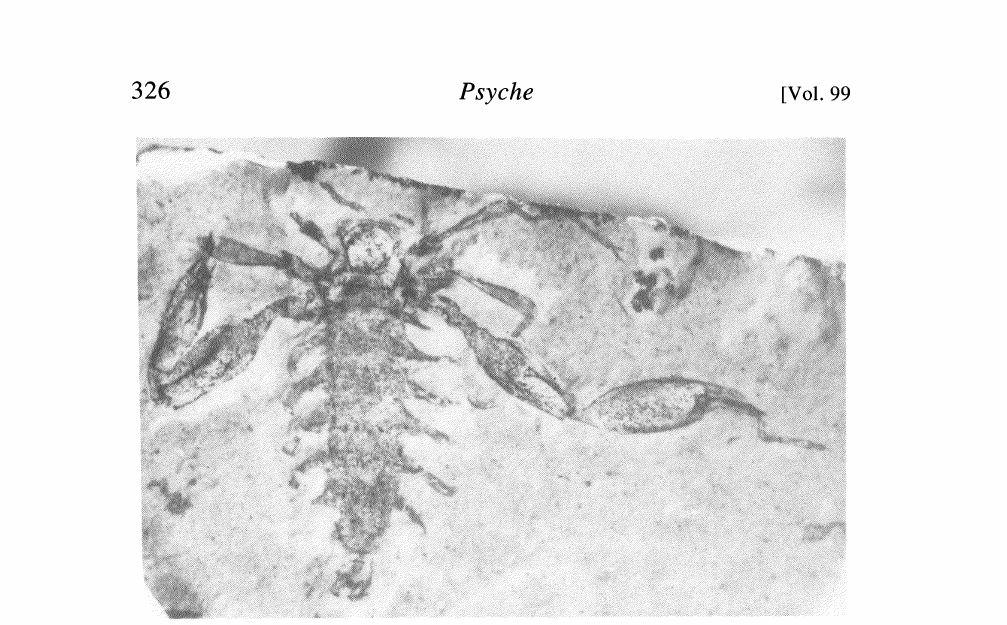
Fig. 1. Strashila incredibilis. Photograph of counterpart of the holotype male. Scale bar, mm.